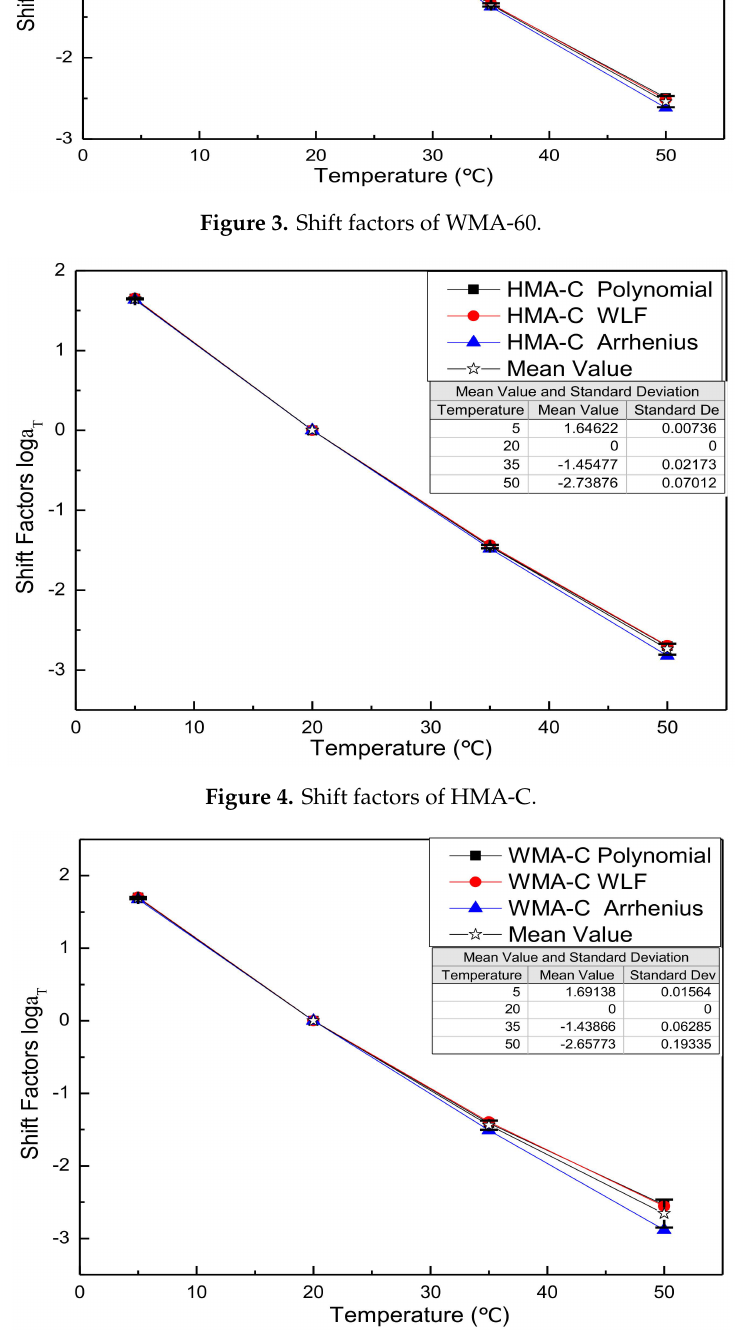
Figure 5. Shift factors of